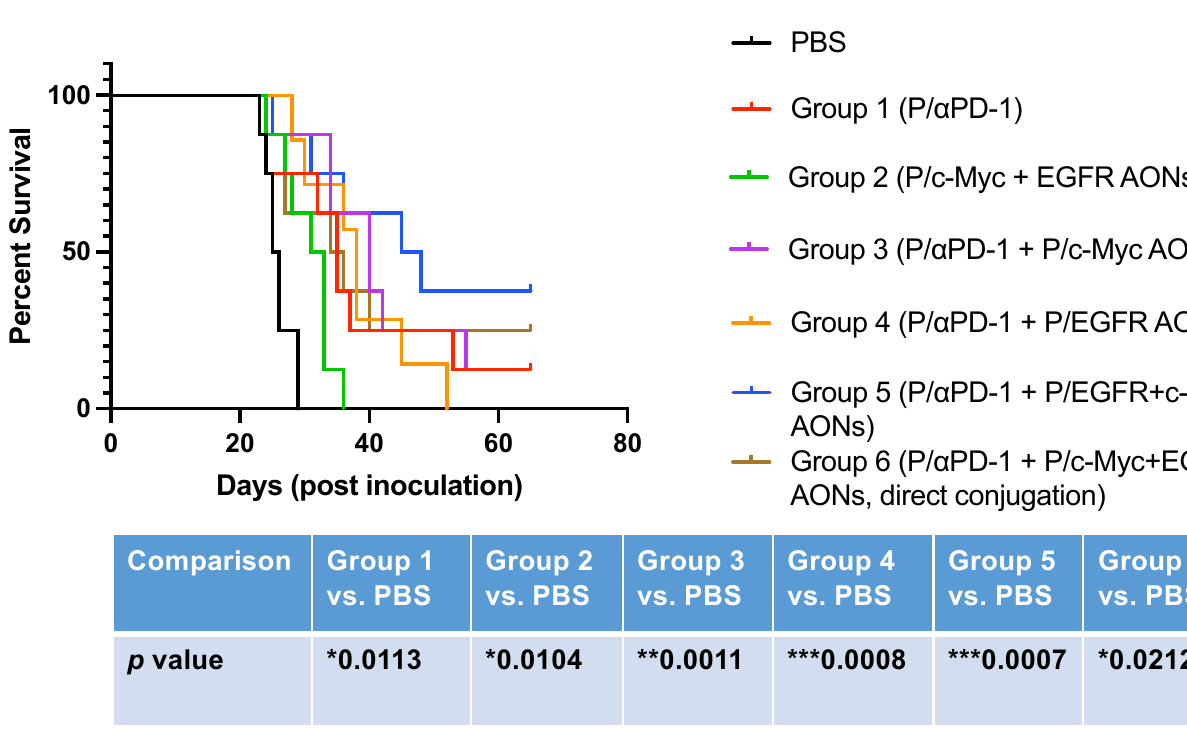
Figure 5. Survival of mice with intracranial GL261 GBM after various MNP treatments. All groups showed significant effect vs. PBS control. The strongest beneficial effects were observed in combination groups, where the inhibition of GBM markers by MNPs was associated with administration of an immunostimulatory checkpoint inhibitor (groups 3–5). “Direct AON” conjugation produced a significant but modest effect suggesting that, for full efficacy, AONs should be cleaved off the PMLA backbone. Combination treatment groups 3–5 were significantly different from PBS and single treatment group